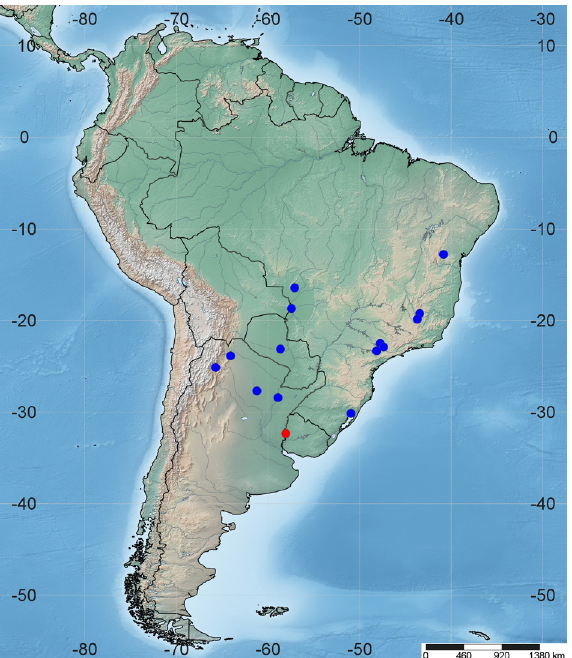
Image 1. Iviraiva pachyura , female (FCE-Ar 4050). A - specimen alive; B - epigyne, ventral view; C - epigyne, dorsal